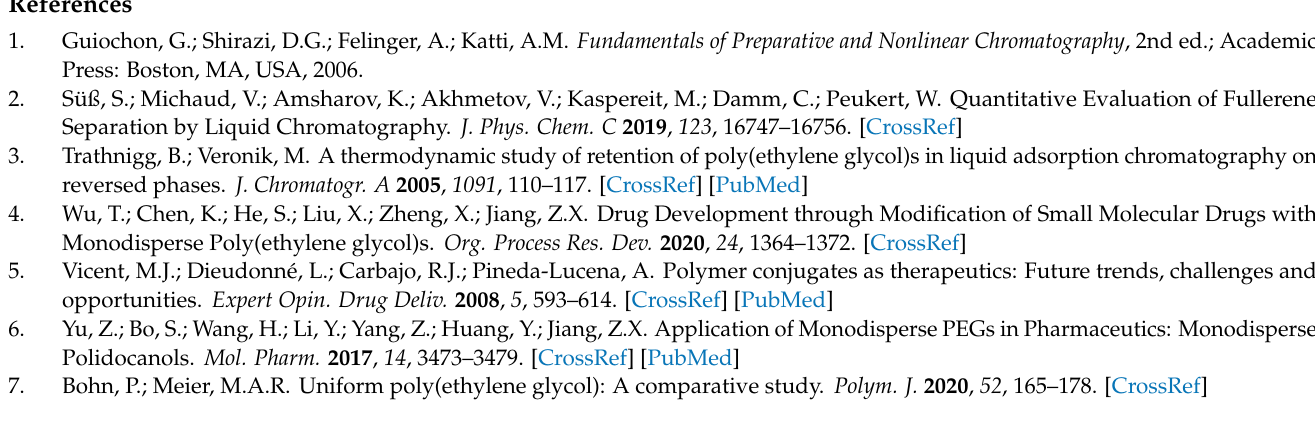
Figure S1: CAD chromatogram and the corresponding total ion count over time for PEG1400 at rate 1mL/min, respectively; S2. Thermodynamic parameters; Figure S2: Three mass spectrograms for three selected peaks at 10, 19 and 34 min derived from the chromatogram of the total ion count (Figure S1). Possible load carriers as well as double (2+) and triple (3+) charged ion sources are marked. The corresponding peaks of the three homologs (n = 30, 35 and 39) are marked in the CAD and MS chromatograms of Figure S1; Figure S3: Determination of thermodynamic parameters at 15 vol % (top) and 17 vol % (bottom) ACN; Figure S4: Determination of thermodynamic parameters at 19 vol % (top) and 21 vol % (bottom) ACN; Figure S5: Determination of thermodynamic parameters at 22 vol % (top) and 23 vol % (bottom) ACN; Figure S6: Determination of thermodynamic parameters at 24 vol % (top) and 27.5 vol % (bottom)